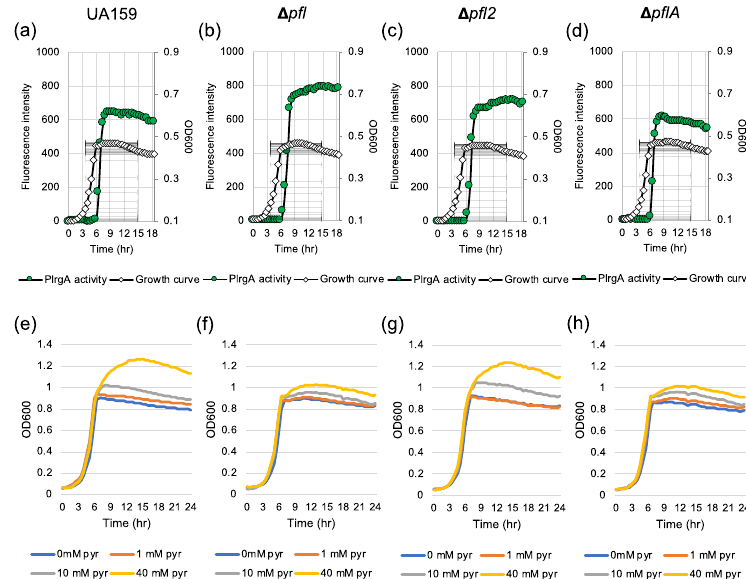
Figure 9. The contribution of the Pfl pathway to stationary phase P lrgA activity ( a – d ) and pyruvate uptake for regrowth ( e – h ). For measurement of P lrgA activation, the P lrgA-gfp reporter strain in the wild type UA159 ( a ), ∆ pfl ( b ), ∆ pfl2 ( c ) and ∆ pflA ( d ) backgrounds, was grown in FMC11 medium. Relative gfp expression (green circle) and cell growth (OD 600 ; white diamond) were monitored during growth on a plate reader (see Materials and Methods for details). For measurement of growth in response to external pyruvate, wild type UA159 ( e ), ∆ pfl ( f ), ∆ pfl2 ( g ) and ∆ pflA strains were grown in BHI, supplemented by different concentrations of pyruvate (0, 10 and 40 mM). Optical density at 600 nm was monitored every 30 min at 37 °C using the Bioscreen C lab system. The results are representative of three independent experiments.